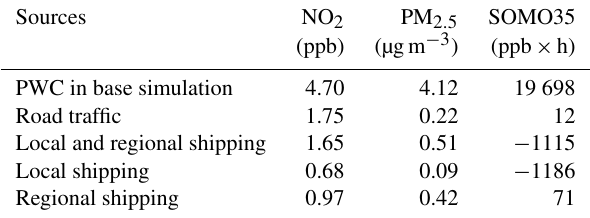
Table 2. Population-weighted annual mean concentrations of NO 2 , PM 2 . 5 and SOMO35 associated with all sources, road traffic and local and regional shipping in the city of Gothenburg for the year